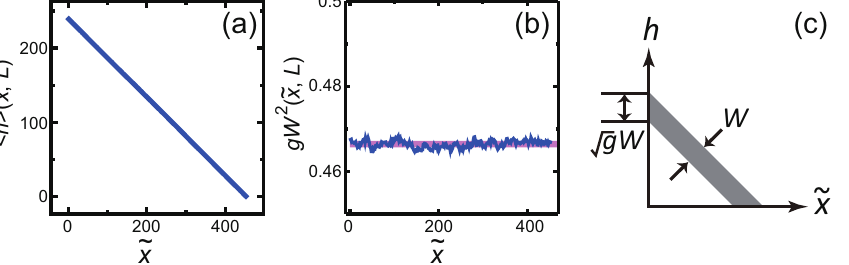
Figure 3. ( a ) ˜ x dependence of (cid:104) h (cid:105) ( ˜ x , t ) (Equation (14)). t = 4 × 10 8 MCS/site. ( b ) Dark full lines: ˜ x dependence of gW 2 ( ˜ x , L ) (Equation (16)). Light thick line: gW 2 ( L ) obtained using the least squares method. ∆ µ = 0. ( c ) The relationship between W and A N step =240. (cid:104) h (cid:105) ( ˜ x , t ) and gW 2 ( L ) are averaged over 2 × 10 8 MCS/site after initial 2 × 10 8